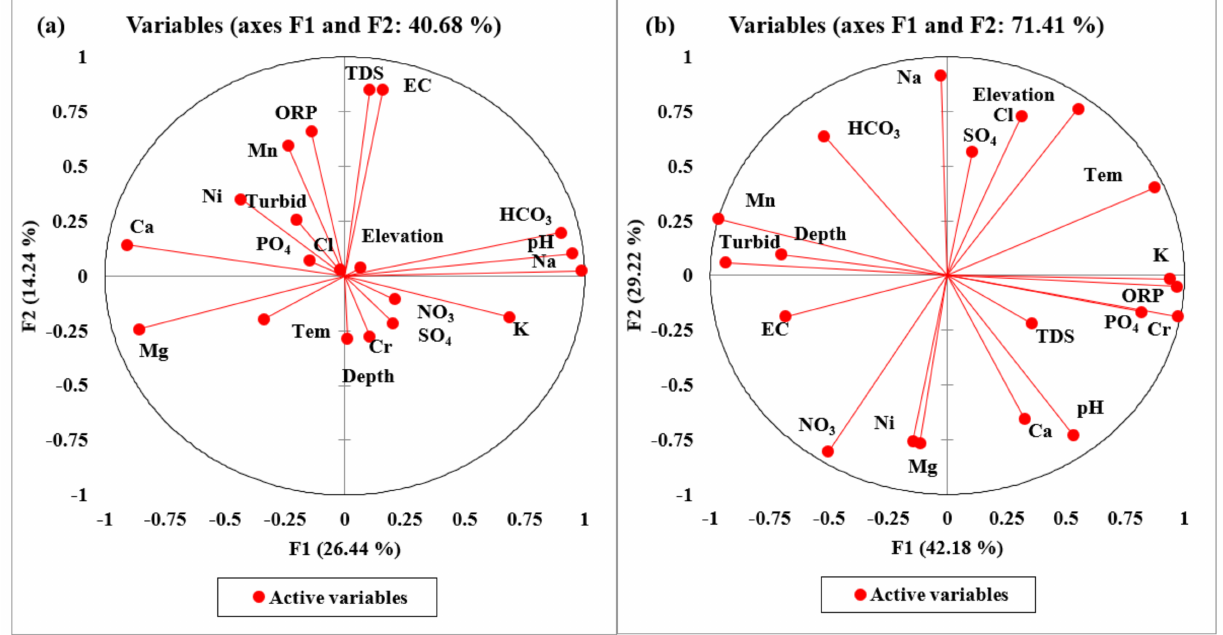
Figure 7. ( a ) Overall loading factors of PCA, and ( b ) relationship of F1 and F2 after varimax rotation in groundwater variables of ultramafic terrain of Malakand, Northern